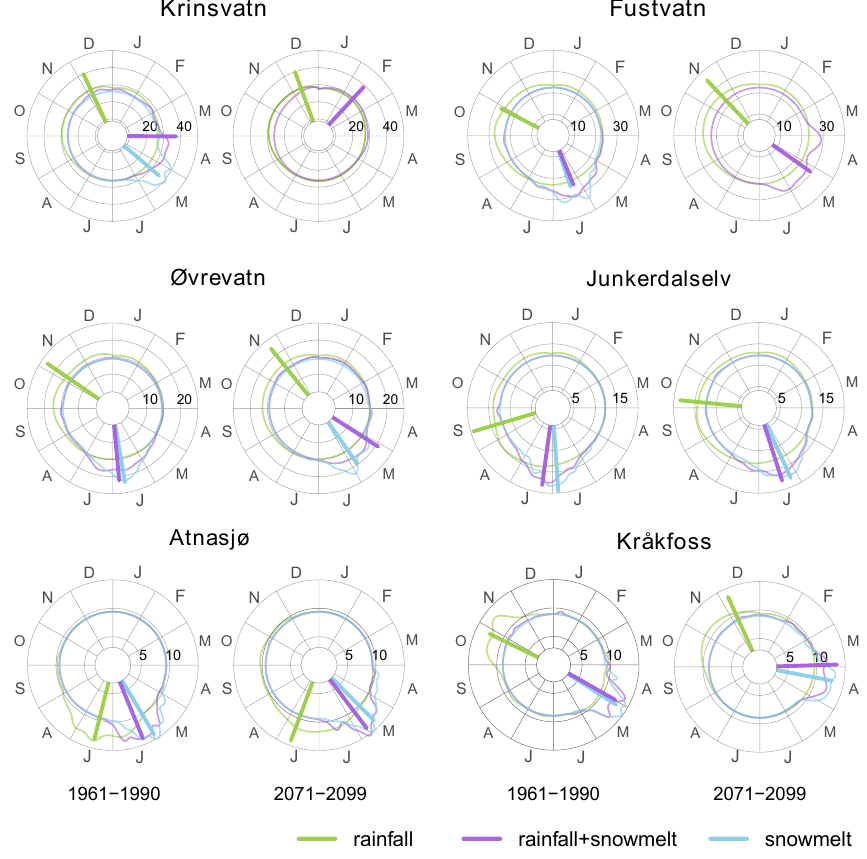
Figure 7. Circular plots showing (i) the circular kernel density function of the simulated POT events according to their FGPs (normalized; no units), and (ii) the median POT-event magnitude (mmday − 1 ) as bars according to their circular mean Julian date of occurrence and their FGPs for the reference and future